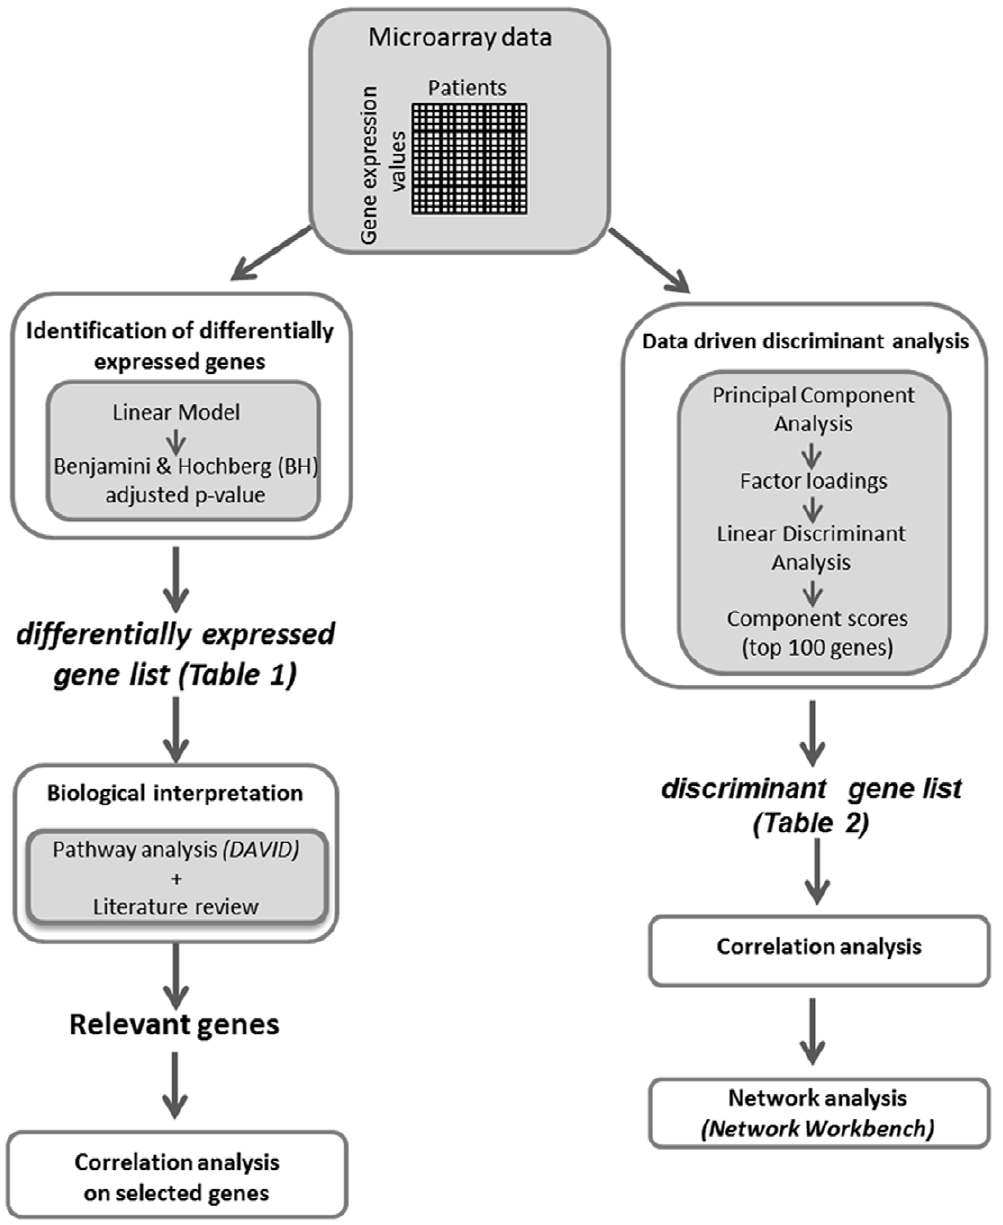
Figure 1. Experimental design. The flowchart schematizes the experimental steps of the statistical analysis of microarray data.